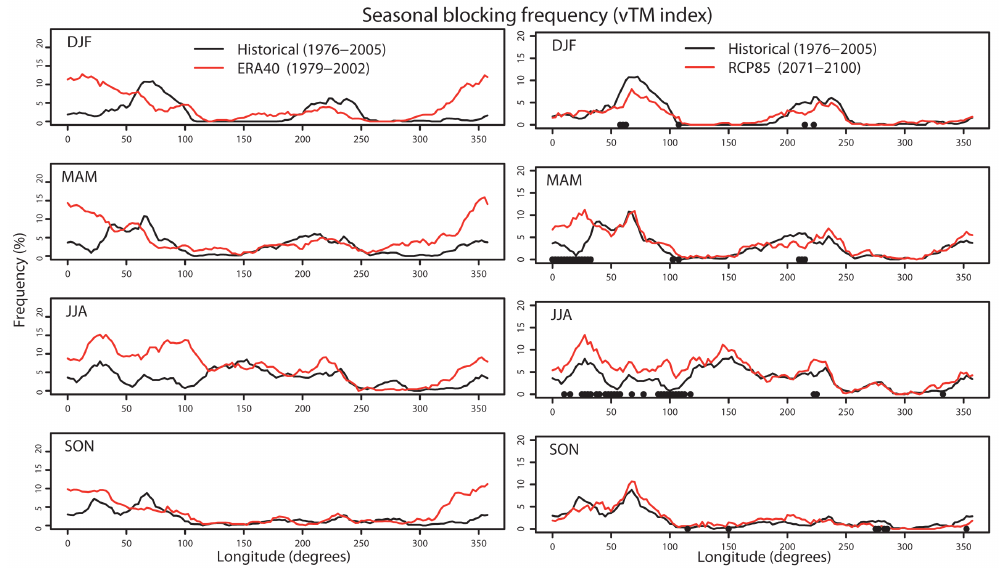
Fig. 13. Northern hemispheric seasonal blocking statistics for the Tibaldi and Molteni (1990) (vTM) index diagnosed relative to the latitudes of the seasonally averaged position of the westerlies (Pelly and Hoskins, 2002). Left panels are for the simulated NorESM1-M Historic1 for 1976–2005 compared to ERA40 statistics for 1976–2002, and right panels are projections for 2071–2100 with the RCP8.5 scenario compared to the period 1976–2005 (Historic1) with NorESM1-M. Dots signify longitudes where differences are significant at the 95% confidence